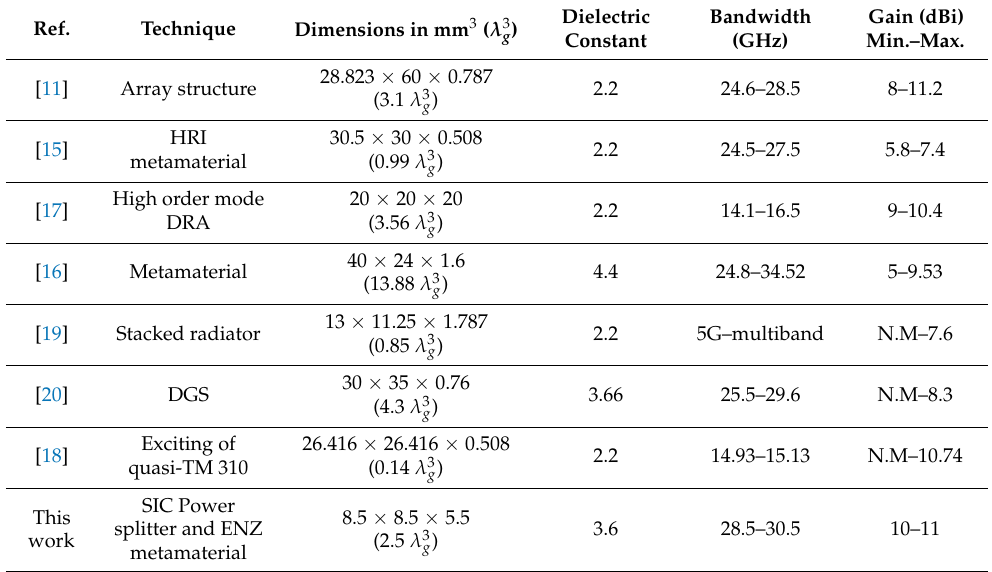
Table 3. Comparison with the state-of-the-art antennas at the sub-millimeter wave range.